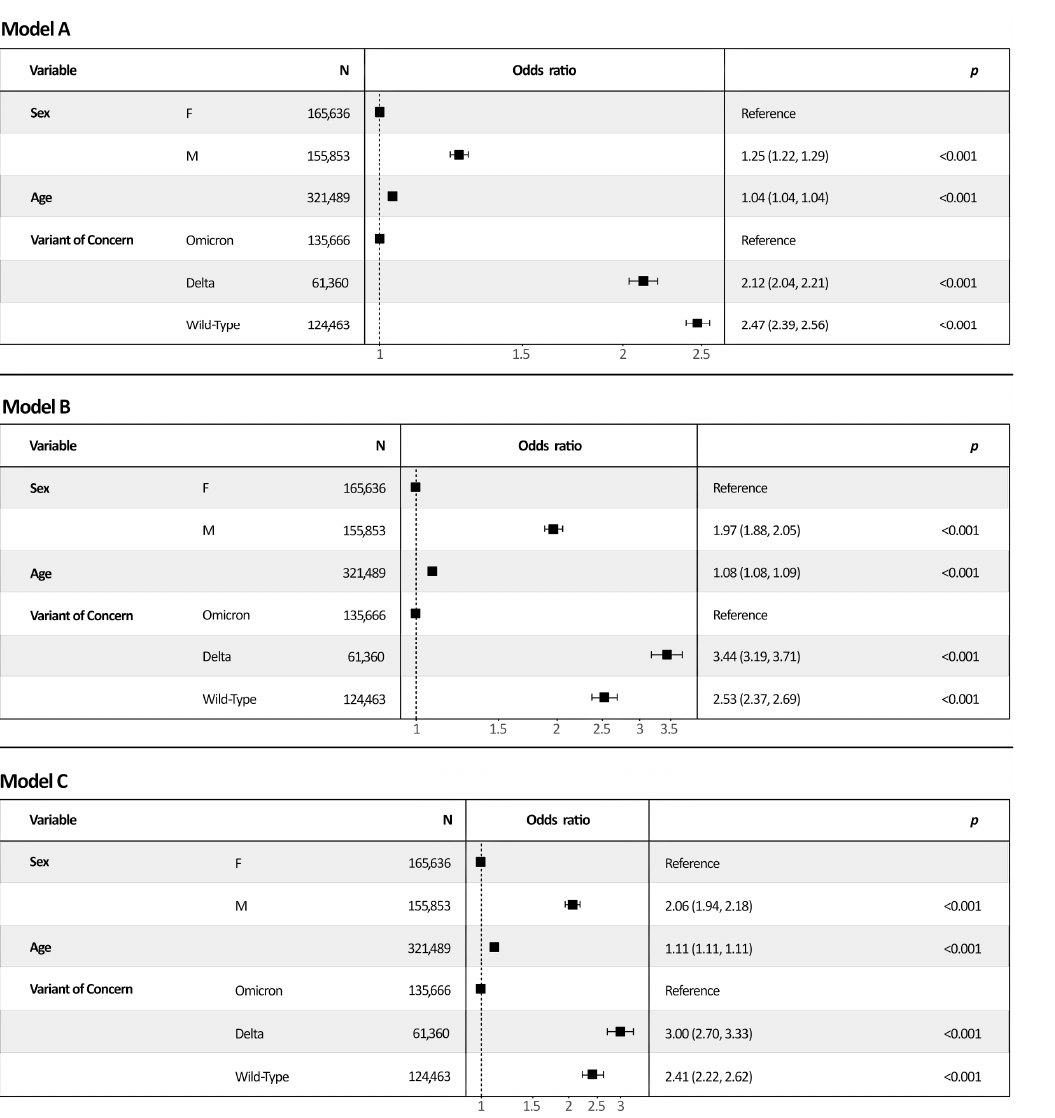
Figure 2. Visual representation of multivariable logistic regression models and odds ratios (95% CI). Legend : Model A included as outcome mild COVID-19 or worse (referent was being subclinical cases); Model B included as outcome severe COVID-19 or worse (referent was having mild COVID-19 or being subclinical cases), and Model C included as outcome intubation/death (referent was having developed mild-to-severe COVID-19 or being subclinical